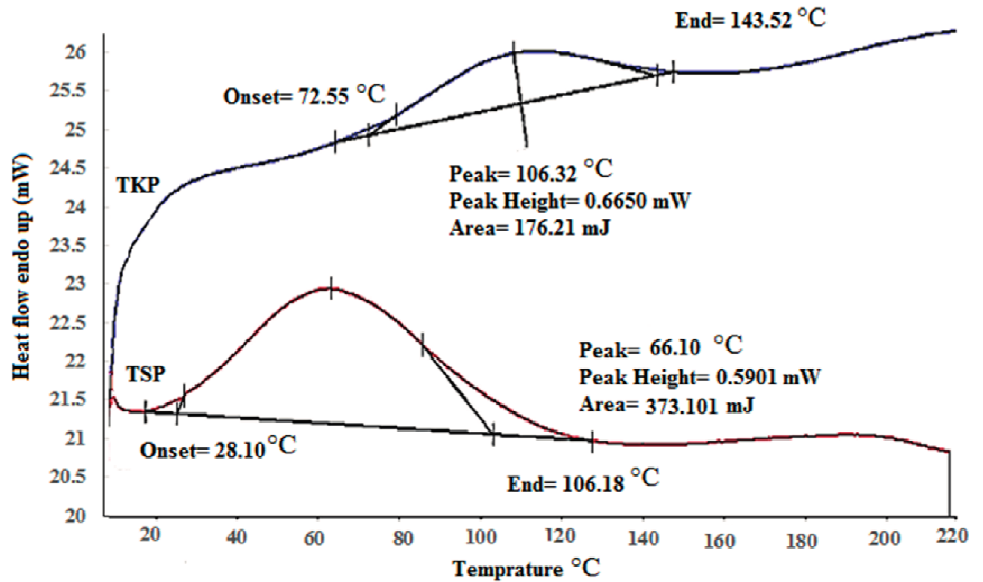
Figure 2. Comparison of differential scanning calorimetry (DSC) curves of TKP and